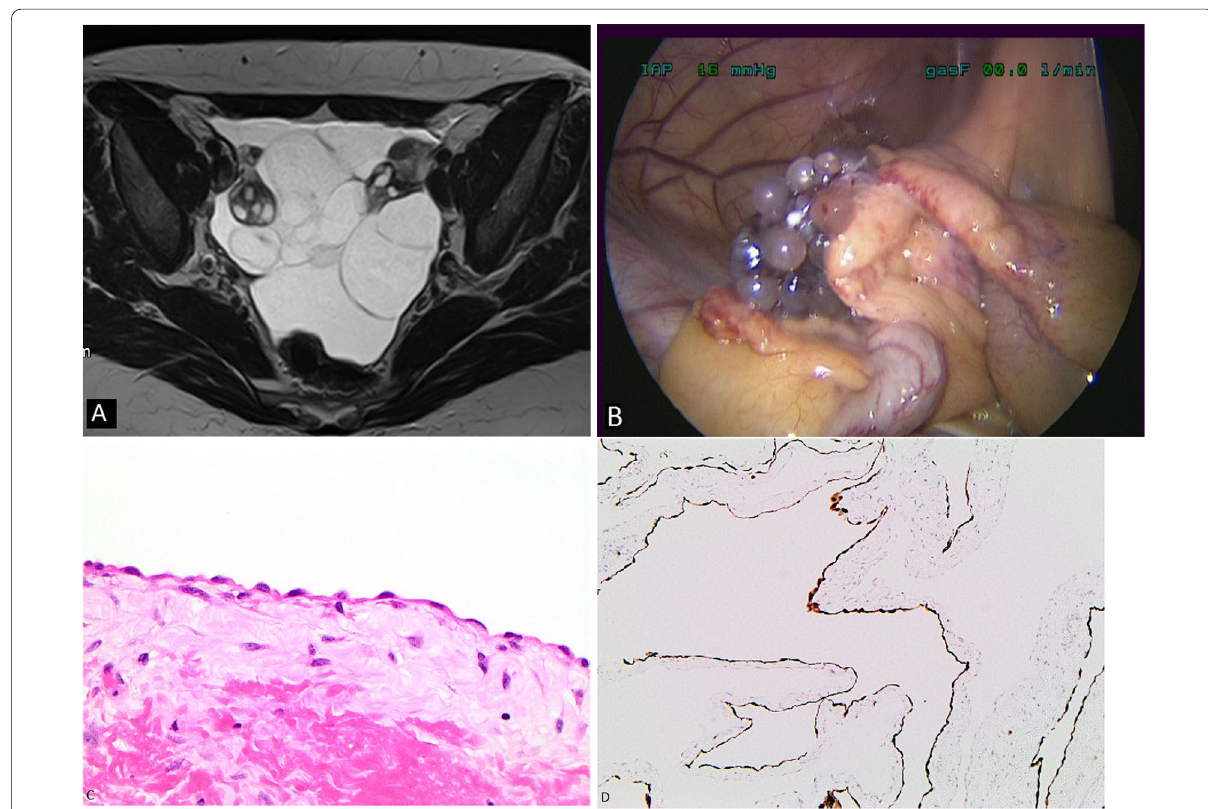
Fig. 1 a – d 40-year-old female with cystic mesothelioma. a MRI T2 weighted axial image of the pelvis shows fluid intensity loculated cystic lesions surrounding the ovaries. b Intraoperative photograph showing the same findings. c High-power photomicrograph (H&E of mesothelial cells lying on a loose fibrous stroma. d Low power photomicrograph ( calretinin expression by the neoplastic cells which outline the shape of the